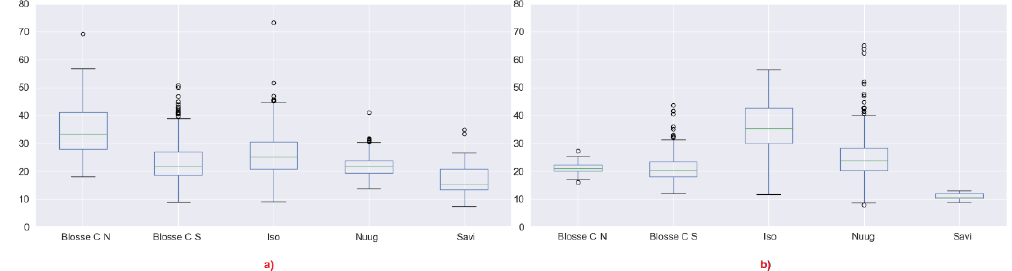
Figure 11. ( a ) Iceberg alpha boxplot 5 × 5 window, ( b ) 11 × 11 window. Significant changes in alpha are evident in Blosseville Coast N and Savissivik.